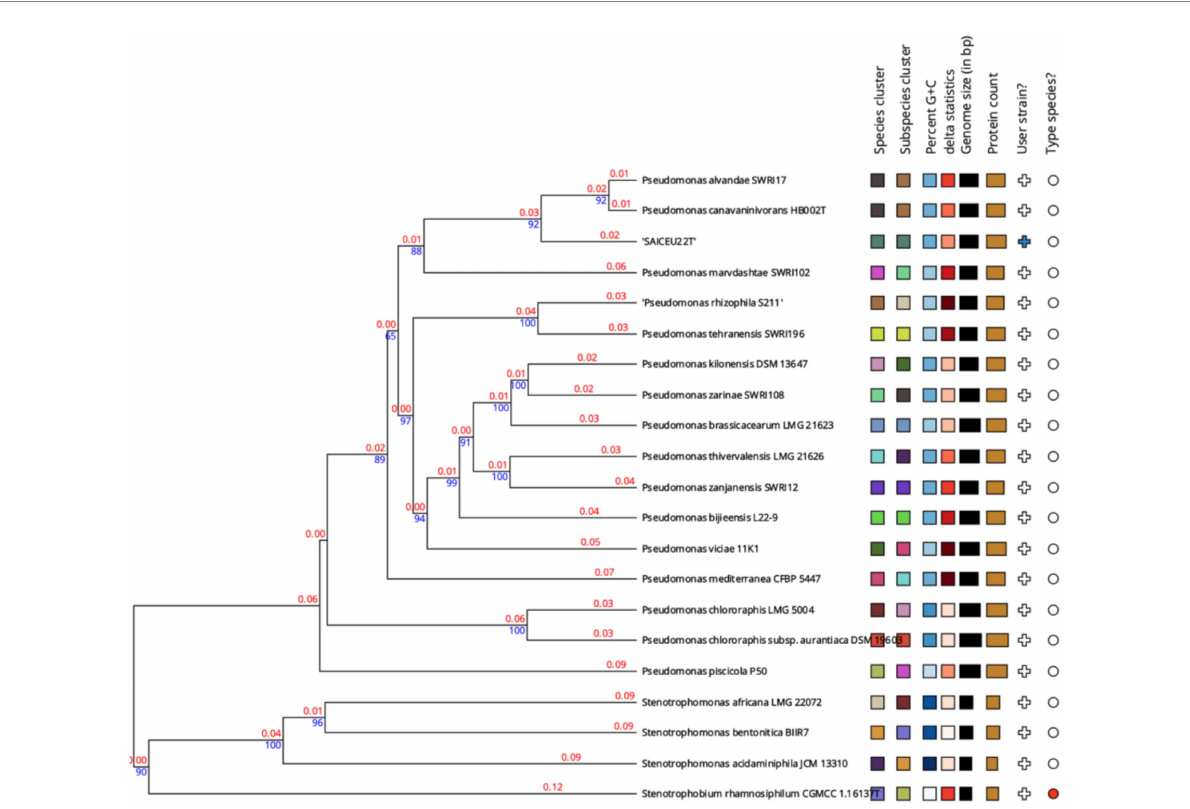
FIGURE 6 Phylogenetic tree from the complete genome of the species of Pseudomonas genus. Numerical values indicate the relative distance between the analyzed species. The branch lengths are scaled in terms of GBDP distance formula d5. The blue numbers are GBDP pseudo-bootstrap support values > 60% from 100 replications, with an average branch support of 55.2%. The branch length values (in red) represent the evolutionary time between two nodes. Unit: substitutions per sequence site. The tree was rooted at the midpoint (Farris,